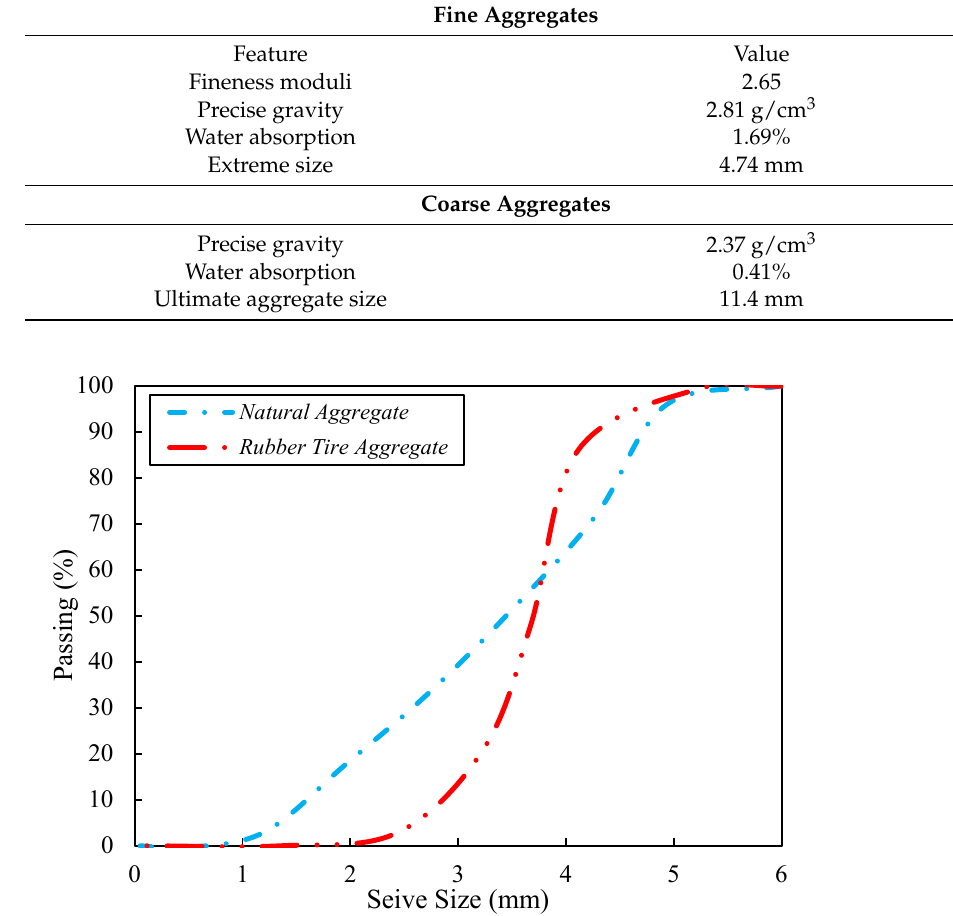
Table 2. Characteristics of the used aggregates.